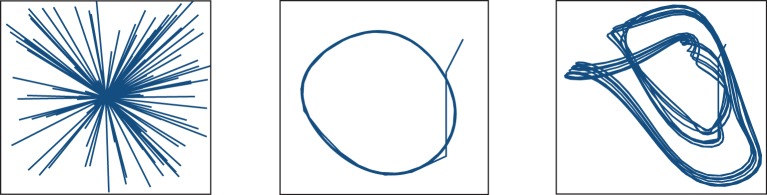
Functions to learn: straight trajectories toward a goal at the center of the surface (left), and following a discretized version of the delay Mackey-Glass differential equation with delays of τ = 5 (center) and τ = 15 (right).